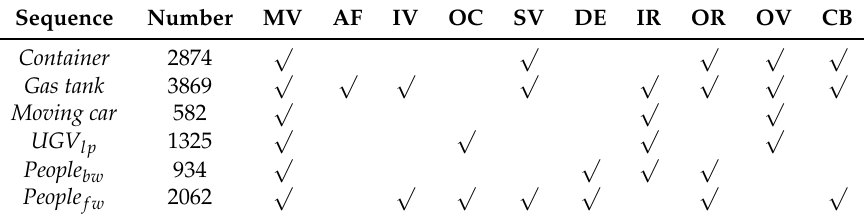
Table 1. Challenging factors of each image sequence. MV: mechanical vibration; AF: aggressive flight; IV: illumination variation; OC: partial or full occlusion; SV: scale variation; DE: deformation,